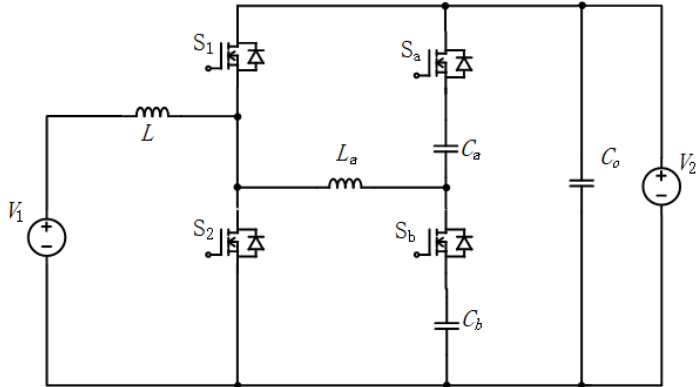
Figure 13. A soft-switching bidirectional buck-boost converter.